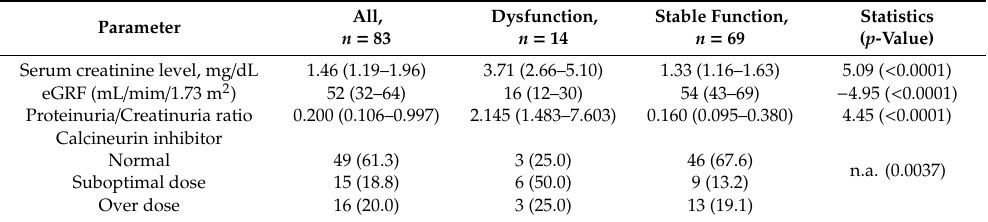
All, Dysfunction, Stable Function, Statistics n = 83 n = 14 n = 69 ( p -Value)